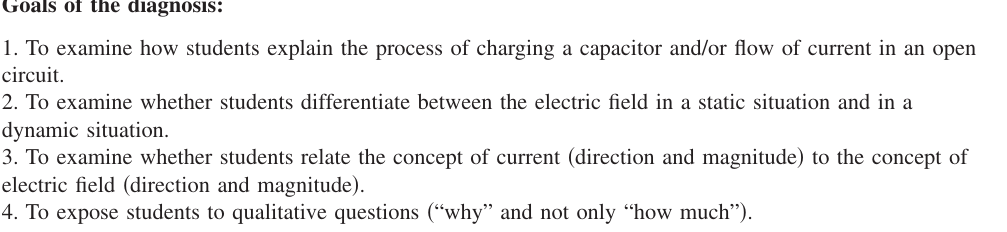
TABLE II. Goals of the diagnostic questionnaire as listed by the teachers. Goals of the